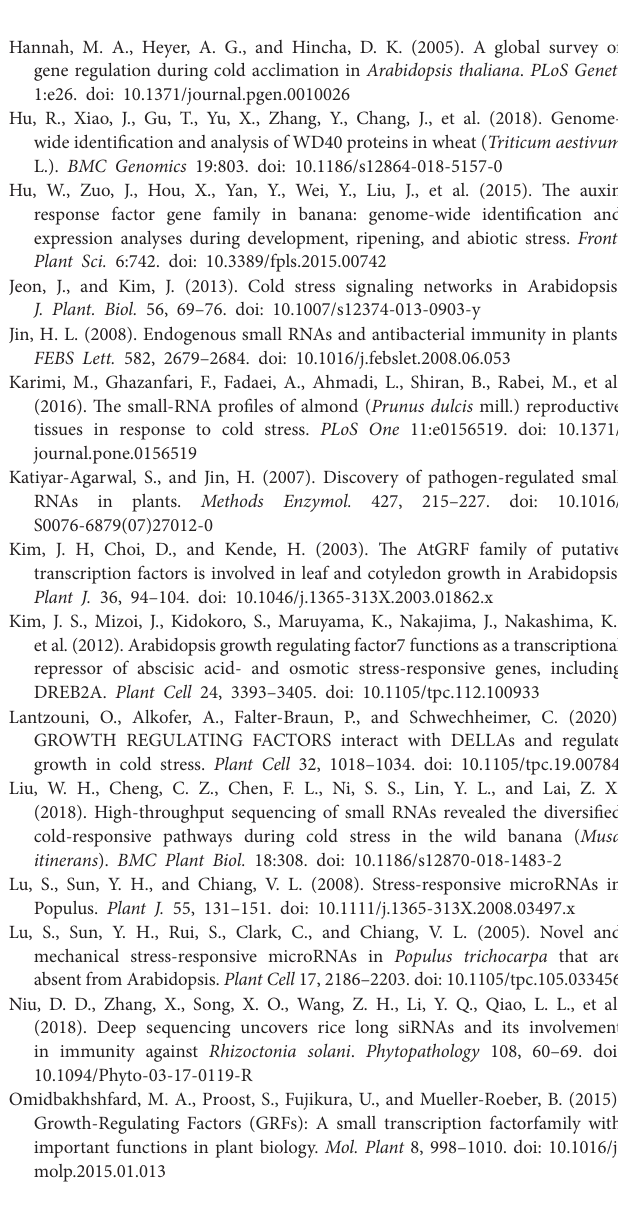
Supplementary Figure S1 | Length distribution and abundance of the sequences. The lengths of the unique, valid reads ranged from 18 to 30 nucleotides (nt), and the 21-24 nt sequences were predominant in all libraries, with the 24 (nt) sequences being the most common. Supplementary Figure S2 | Examples of T-plots of miRNA targets in two peanut RILs confirmed by degradome sequencing. The T-plots show the distribution of the degradome tags along the full length of the target mRNA sequence. The vertical red line indicates the cleavage site of each transcript and Supplementary Figure S3 | Examples of T-plots of miRNA targets in two peanut RILs confirmed by degradome sequencing. The T-plots show the